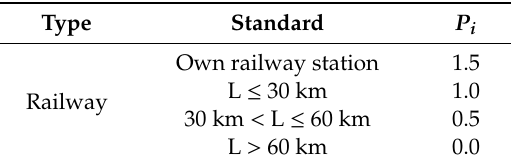
Table 2. Proximity of a railway network.